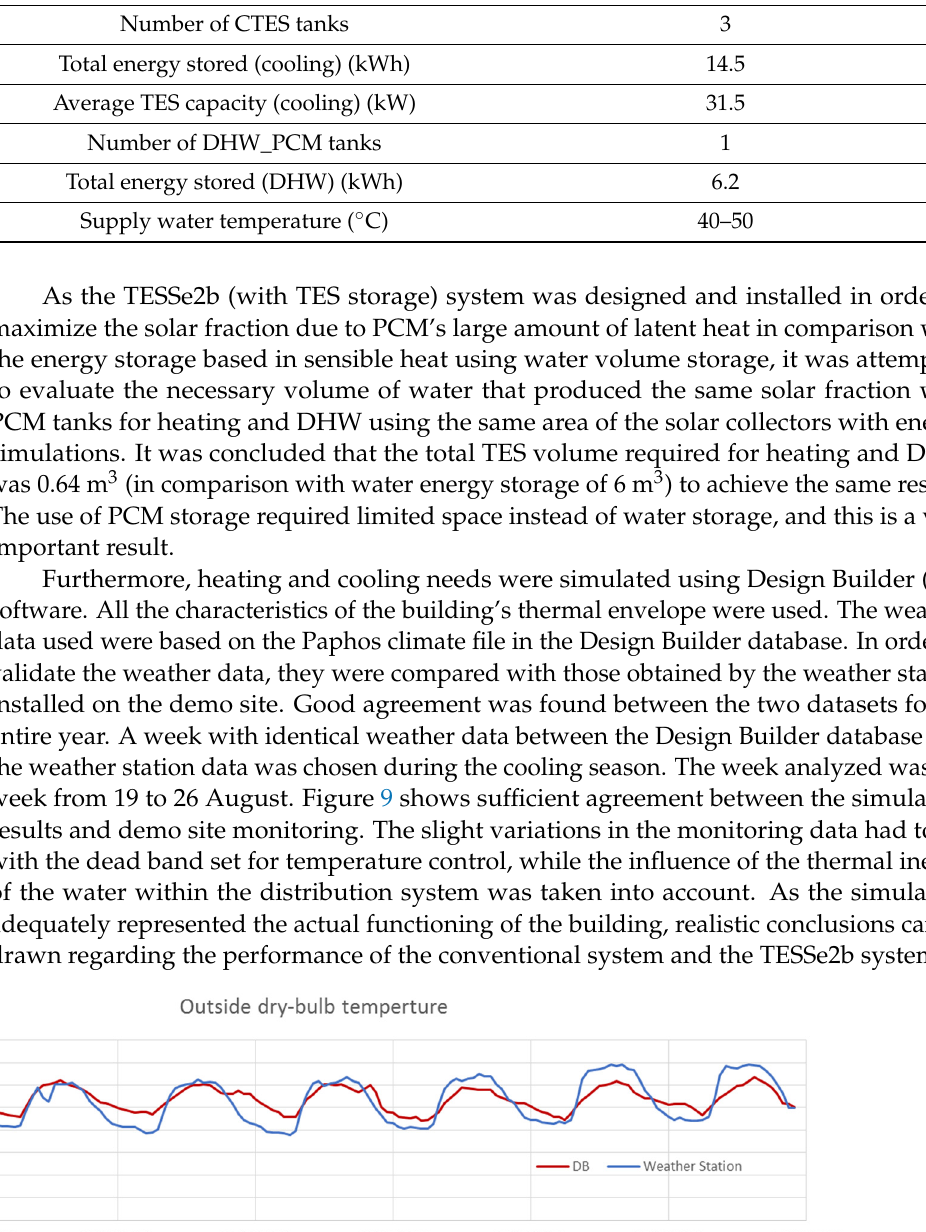
Figure 10. Cooling delivered to the house by the TESSe2b system and cooling needs obtained by the DB simulations. The energy delivered by the TESSe2b system to the building that week to meet its cooling needs was 806.7 kWh, while the value predicted by the simulations was 846.7 kWh, showing a relative difference of 5.1%, which is considered acceptable. In Figure 11, the solar radiation calculated by the software and measured by the weather station is shown. Paphos is on the coast, and the demo site, despite being located near Paphos, was a little further inland, which yielded a slightly higher daily thermal am- plitude. However, it was considered that the agreement between the weather data was adequate for the analysis performed. Figure 11. Solar radiation intensity on a horizontal surface recorded by the weather station and from the DB climate data file for the Cyprus simulations. Figures 12 and 13 present the DHW TES tank performance based on the monitoring data recorded on 24 August 2019. During the cooling season, the solar collectors only pro- vided thermal energy to the DHW TES tank. The level of charge of the DHW TES tank depended on the balance between the solar energy available and the rate of DHW con-